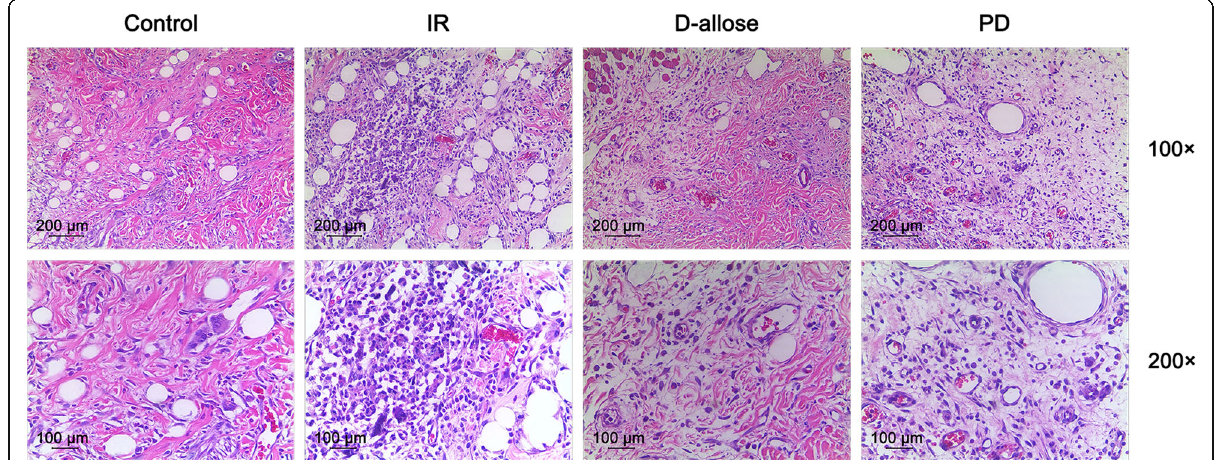
Fig. 2 D-allose alleviated pathological condition of skin flap injured by I/R in Control, IR, D-allose and PD